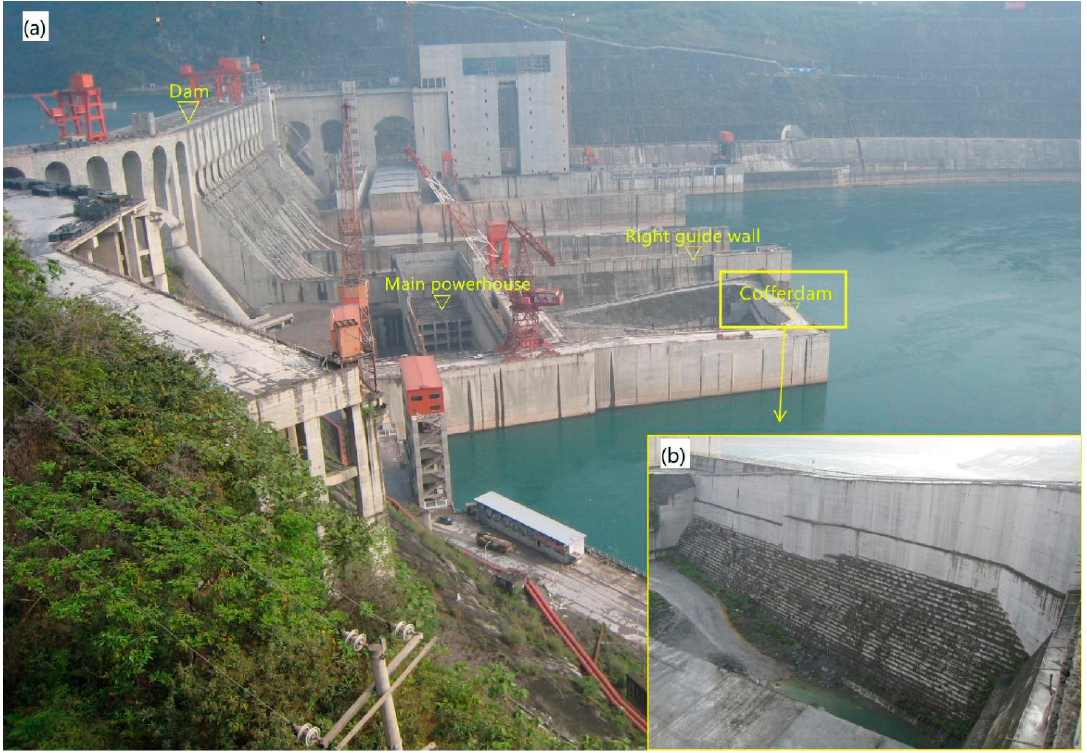
Figure 1. Actual photo of transverse cofferdam in Xiangjiaba hydropower station. ( a ) Aerial view, ( b ) detail picture.